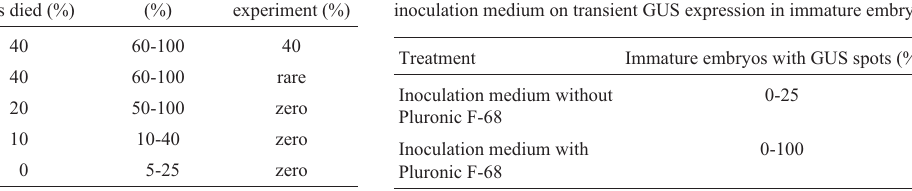
Table 3 - Effect of Agrobacterium concentration on the rate of embryo survival and transient GUS expression. The experiments were conducted using co-cultivation in I6As medium and an average of five replicate experiments with 50 embryos in each experiment. Number of Experiments in Agrobacterium * which all the em- bryos died (%)